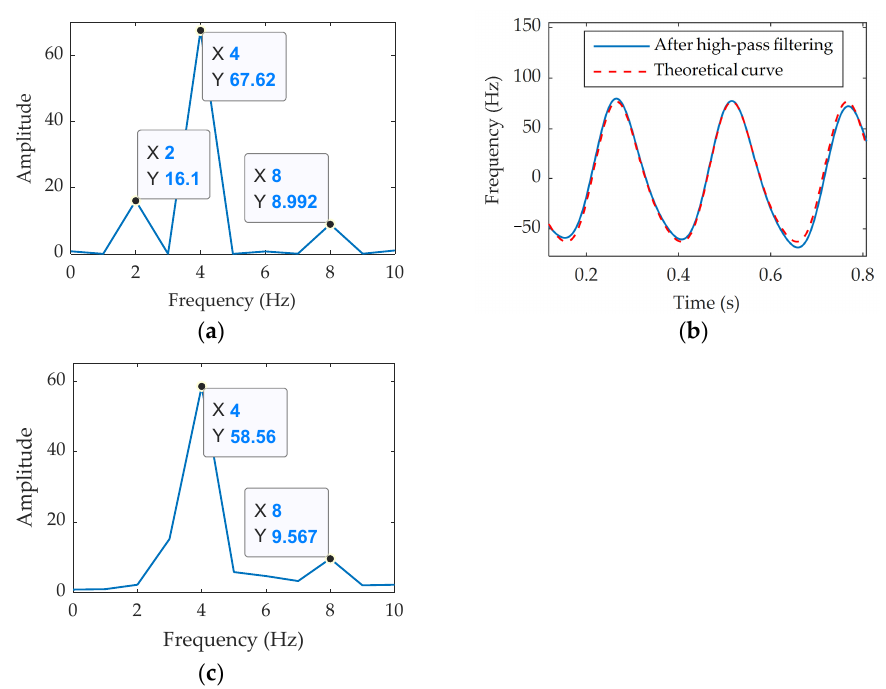
Figure 7. The filtering processing. The spectrum of the curve after interference processing in time- frequency domain ( a ); The filtered curve ( b ); The spectrum of filtered curve ( c ). Parameters are initialized as follows: C 0.025 π . The energy threshold is set as δ = 0.1 . The final micro-Doppler curves of and P are decomposed and reconstructed by the OMP algorithm, respec- scatterers P 1 2 ( tively. After one iteration, the estimated values of